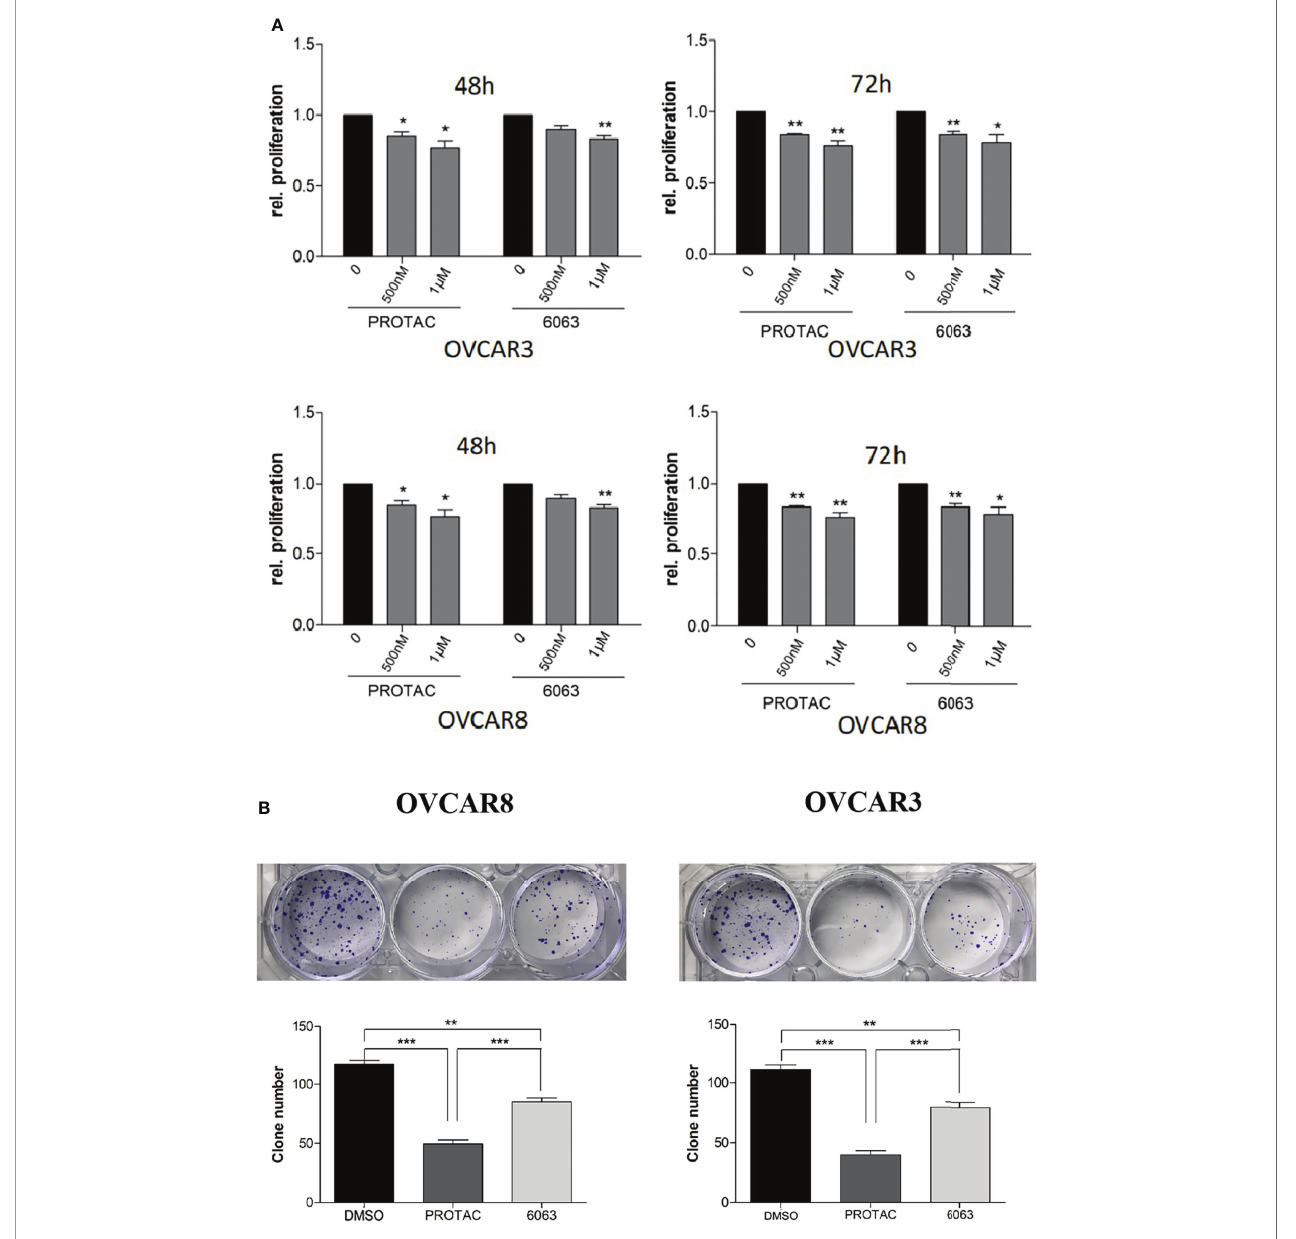
FIGURE 3 | FAK PROTAC is more effective in inhibiting OC proliferation and clone formation. (A) Cell proliferation was detected by MTT assay following treatment of OVCAR3 and OVCAR8 with 1 µM FAK PROTAC and VS6063 for 48 or 72h. (B) Cell colonies were stained with crystal violet and counted following 0.5 µM VS6063 and 0.5 µM PROTAC treatment of OVCAR3 and OVCAR8 for two weeks. (* p <0.05; ** p <0.01; *** p